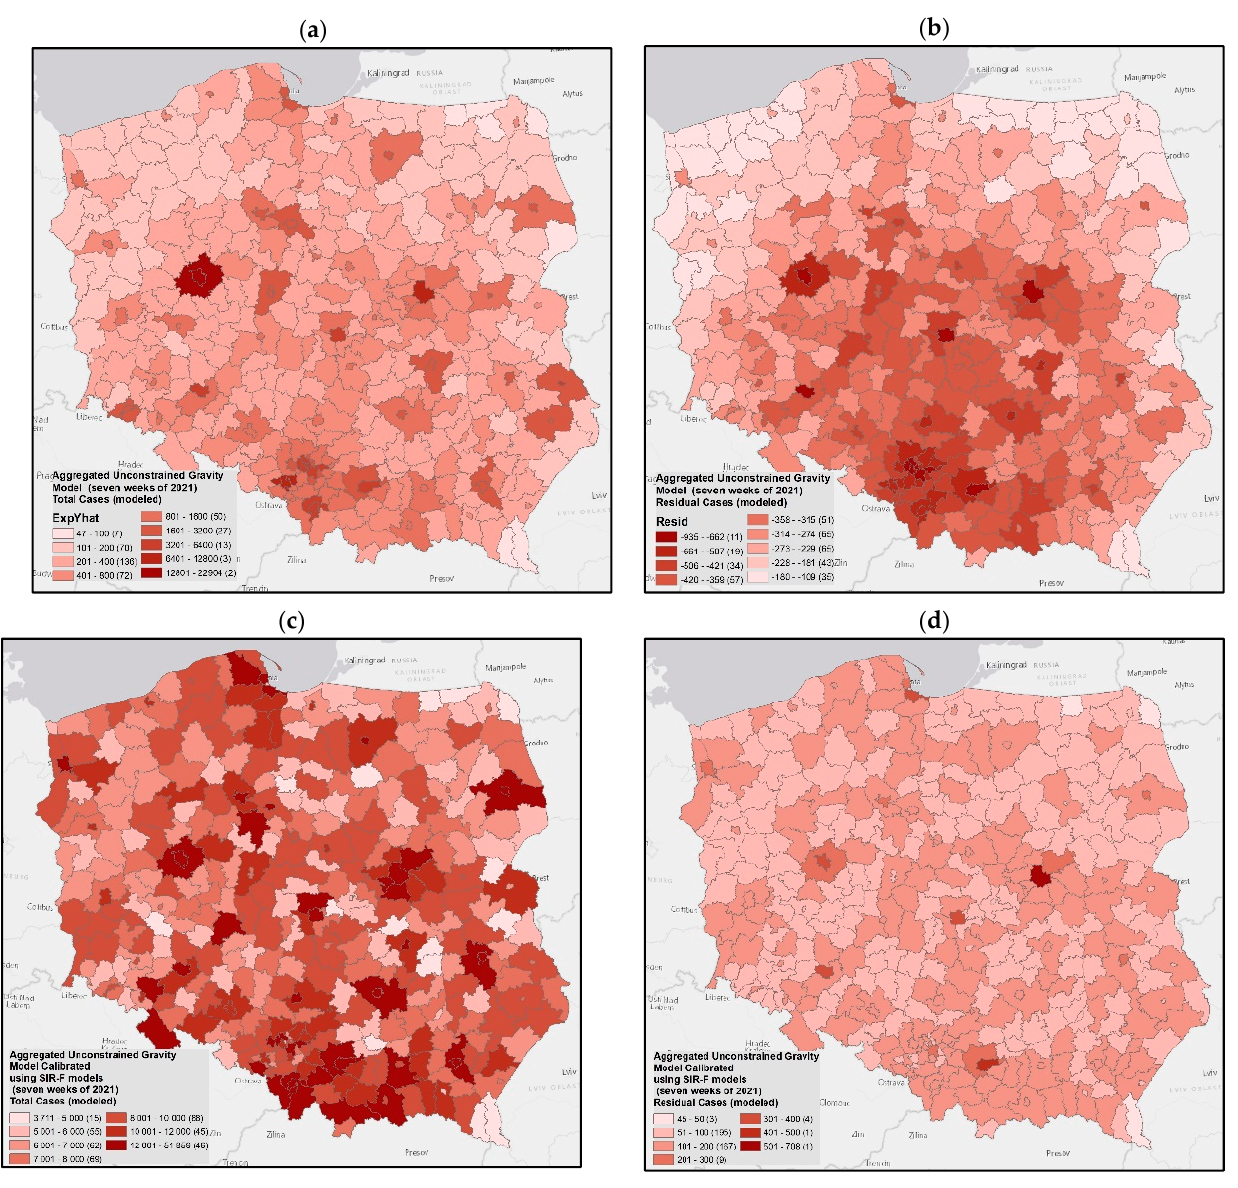
Figure 8. Simulation of COVID-19-infected cases in Poland; ( a ) model of infected cases—seven weeks of 2021; aggregated unconstrained gravity model; ( b ) Residuals of infected cases—seven weeks of 2021; aggregated unconstrained gravity model; ( c ) Simulation of infected cases based on seven weeks of 2021; aggregated unconstrained gravity model calibrated using SIR-F models; ( d ) Simulation of infected cases—seventh week of 2021; aggregated unconstrained gravity model calibrated using SIR-F models.